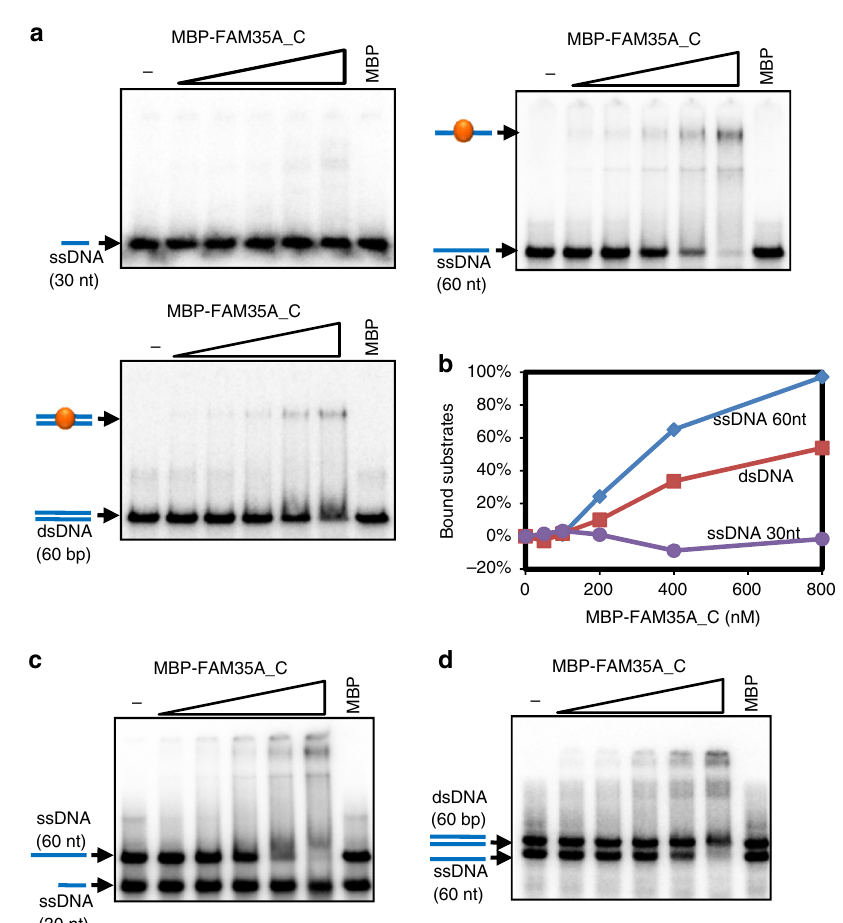
Fig. 2 FAM35A prefers to bind ssDNA. a , b Gel-shift assay ( a ) and its quanti fi cation ( b ) shows that MBP-FAM35A_C (381 – 904 aa) prefers to bind ssDNA. Reactions contained 5 nM of the indicated 32 P-labeled substrates and 0, 50, 100, 200, 400 or 800nM puri fi ed MBP-FAM35A_C or 800 nM MBP. c , d Competition experiments between 60 nt ssDNA and 30 nt ssDNA ( c ) or 60 bp dsDNA ( d ) for MBP-FAM35A_C binding